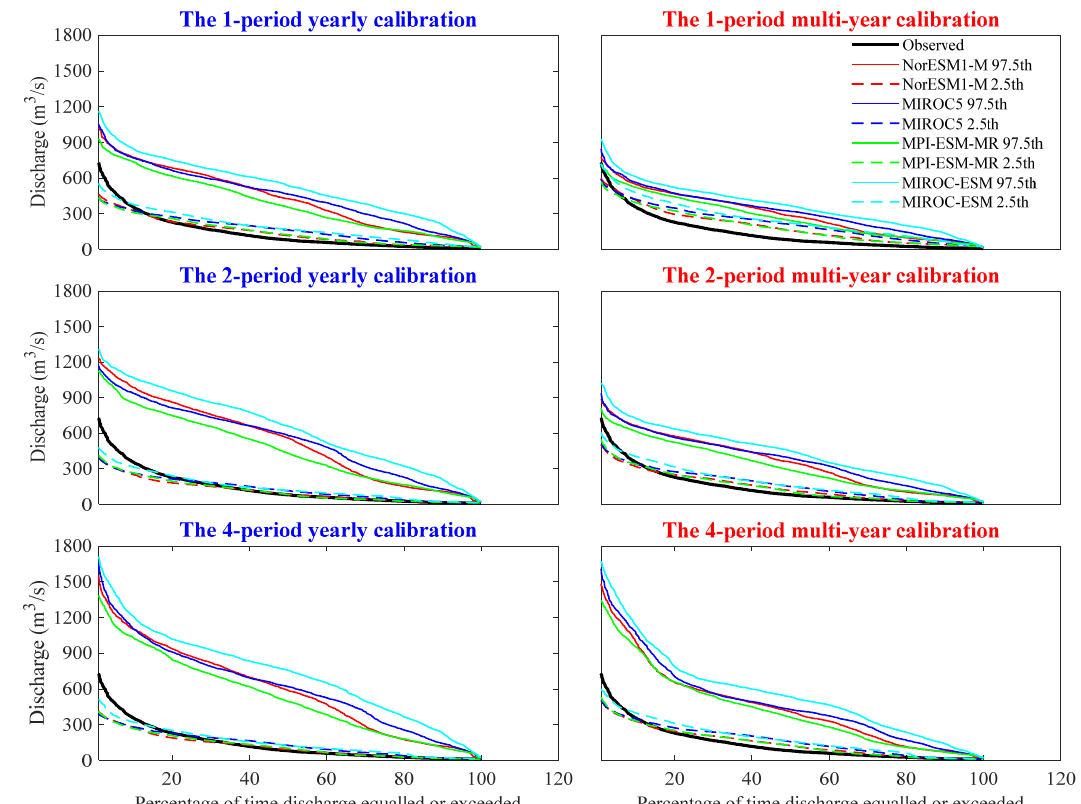
Figure 10. The 95% confidence intervals for the GCM–SRM predicted flow duration curves under RCP8.5 (Period 2041–2050) compared with the observations (Period 2003–2012) shown as black line. The dotted and solid lines represent the 2.5th and 97.5th percentile values, respectively.